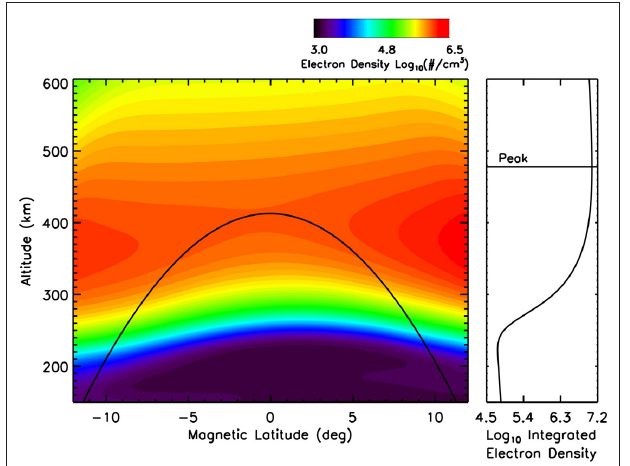
FIGURE 1 | The (Left) shows the electron density (log 10 cm − 3 ) as a function of latitude and altitude at 0 ◦ longitude. The black line denotes a field line with an apex of about 400 km altitude. The (Right) shows the field line integrated electron density as a function of altitude. The peak of the integrated electron density occurs around 480 km altitude.